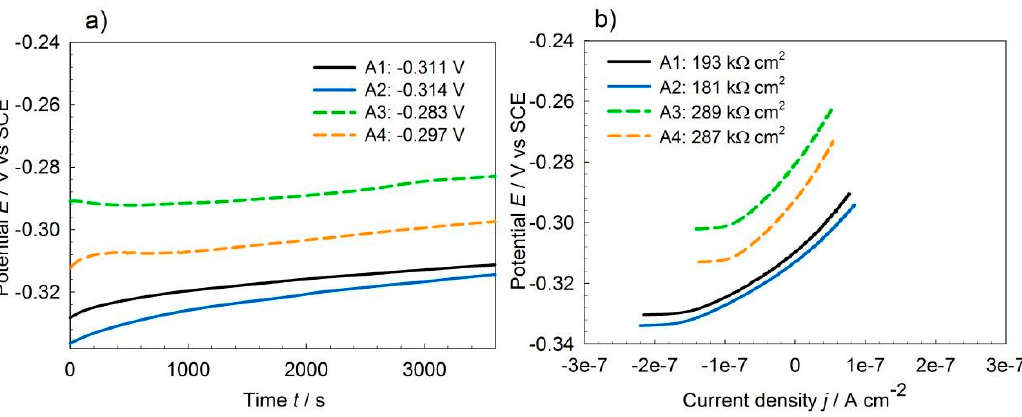
Figure 7. ( a ) Corrosion potential measurements; ( b ) linear polarization measurements; for series A steels in a Na-tetraborate buffer, pH = 10, at a scan rate of 0.1 mV/s.